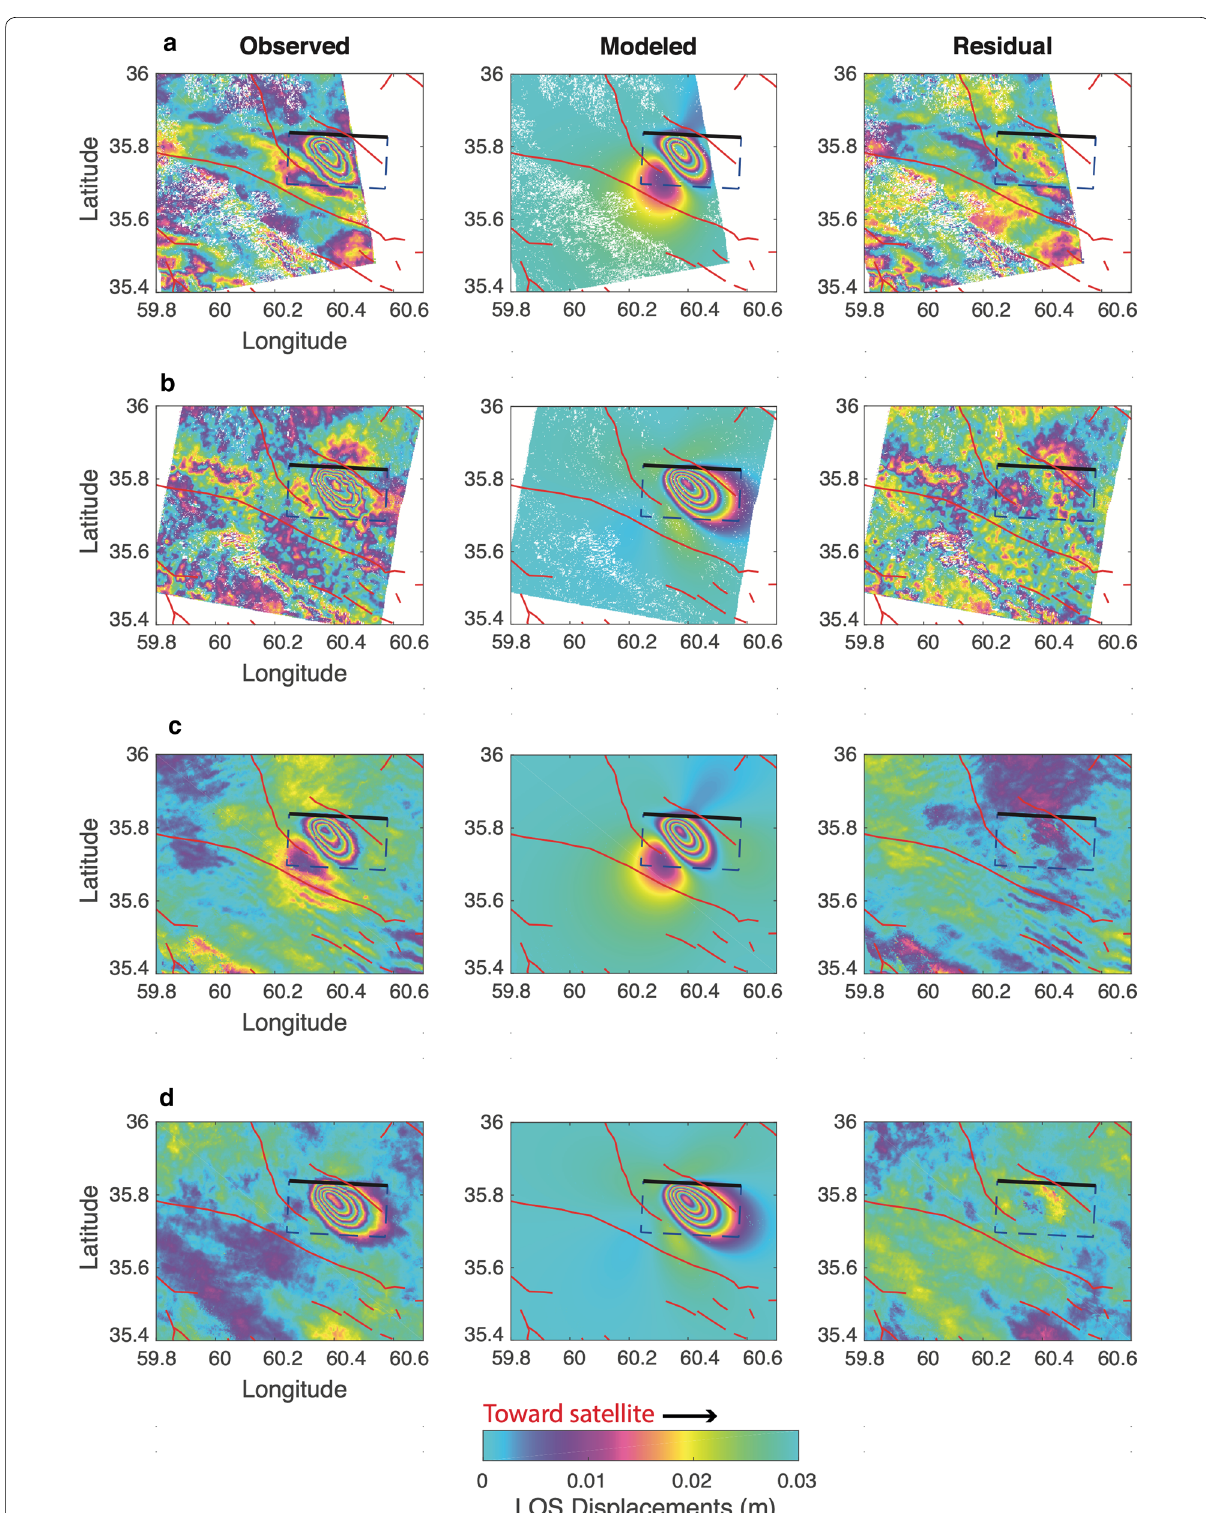
Fig. 9 Observed, modeled and residual interferograms for the south-dipping fault model. a , b ALOS-2 ascending and descending datasets, respectively. c , d Sentinel-1A ascending and descending datasets,